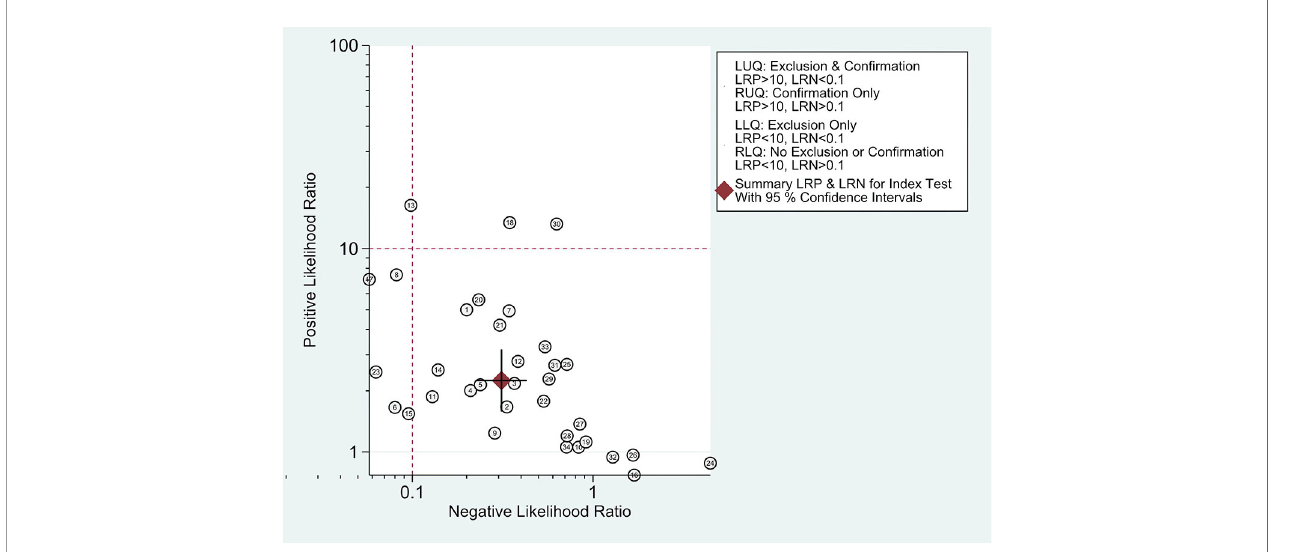
FIGURE 10 | The likelihood ratio scattergram.